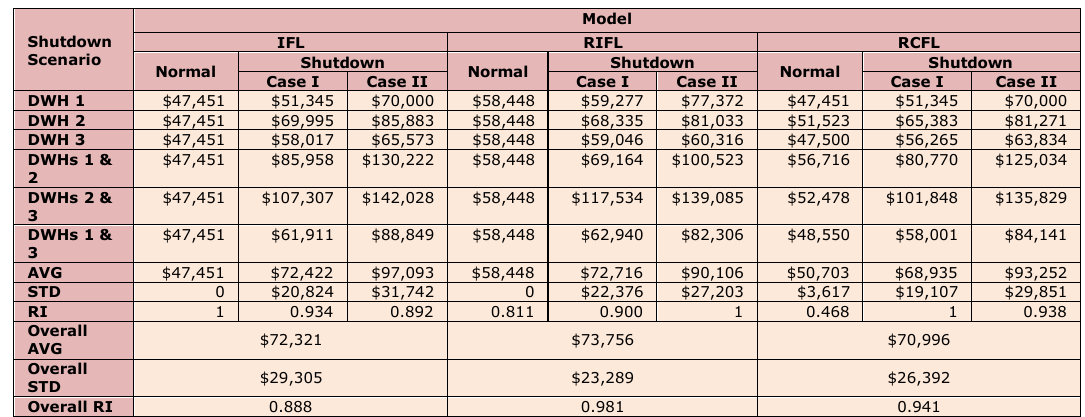
Table 3. Comparison between integrated and two robust